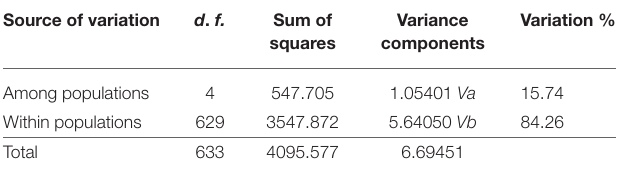
TABLE 4 | Results of